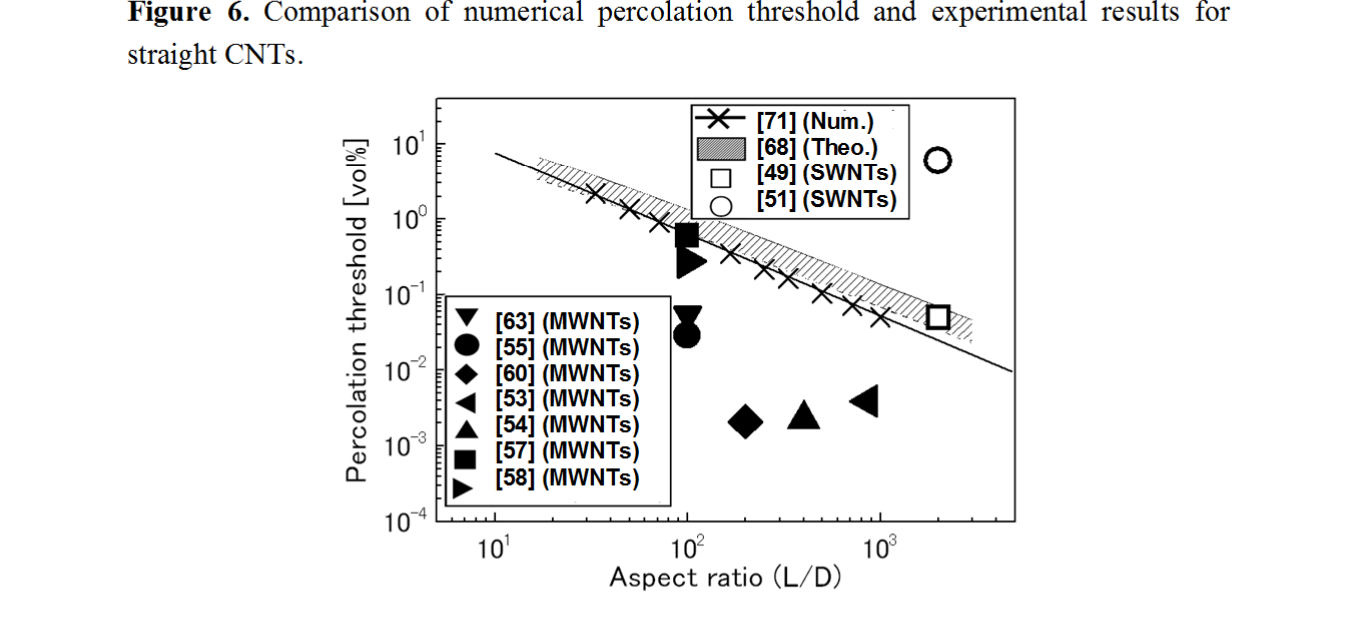
Figure 6. Comparison of numerical percolation threshold and experimental results for straight